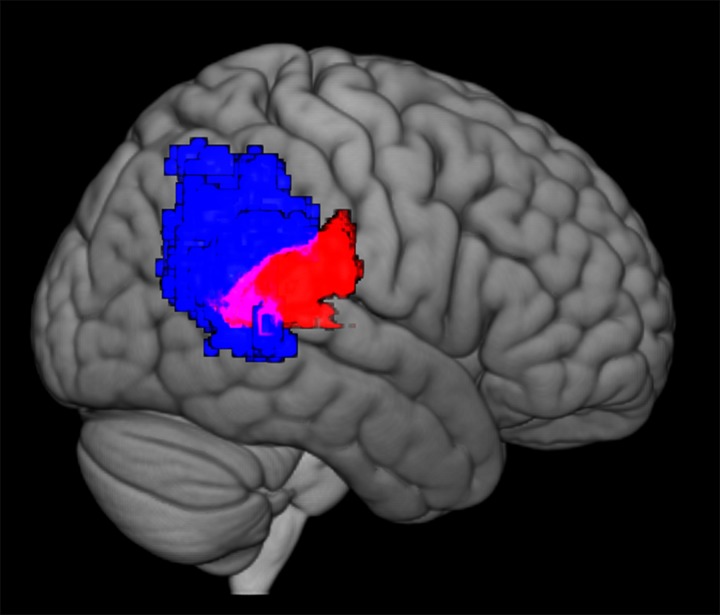
Overlap of neurosynth right TPJ and gesture > color activity.Red area represents left temporal-parietal region of activity from the Gesture > Color contrast, p<0.001. Blue area shows forward inference map of the rTPJ from Neurosynth (http://neurosynth.org) meta-analysis of 92 studies. Black dotted line surrounds area of overlap.